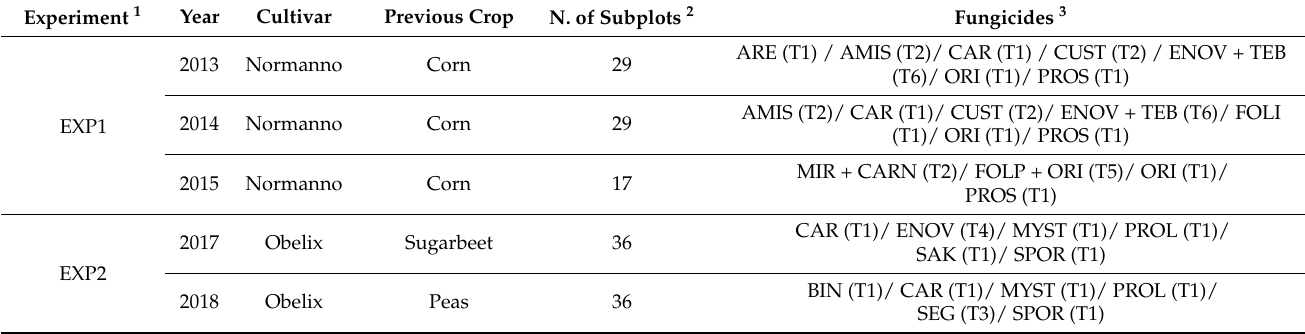
Table 1. Main characteristics of the experiments carried out at Ravenna, North Italy, for the control of Fusarium head blight with different fungicides and different application times (application times were based on wheat growth stages in EXP1 and on days before or after artificial inoculation of wheat spikes with Fusarium graminearum in